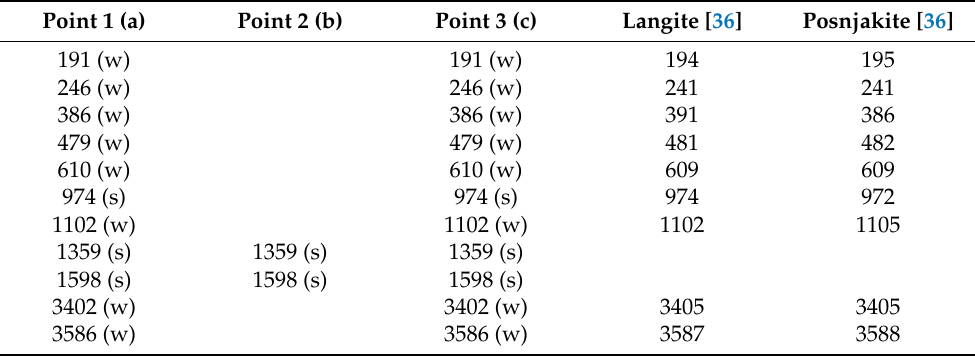
Figure 7. Raman spectra collected on patina samples from MC: position 1 ( a ), position 2 ( b ), and position 3 ( c ). Table 4. Raman bands, analyzed on patina at different positions on statue MC (Figure 7) and literature data [36]. Letters next to a number denote strength of the band: vw (very weak), w (weak), s (strong), and vs (very